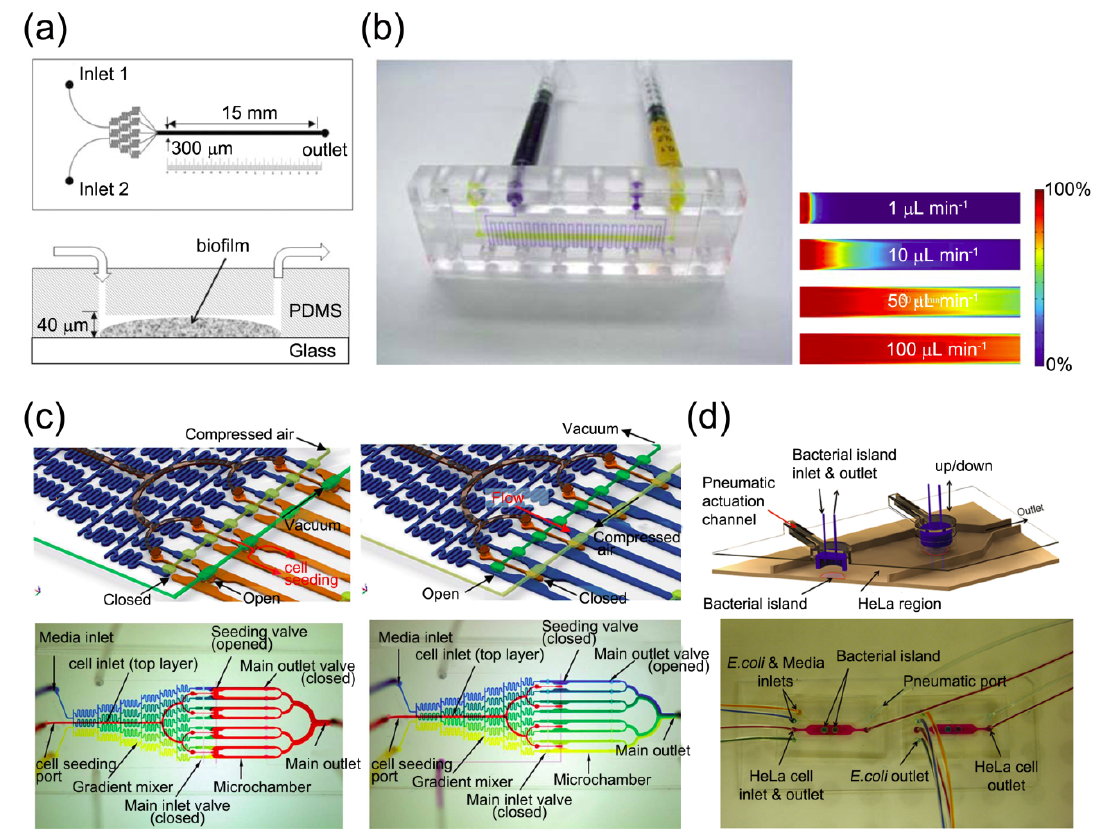
Figure 3. Microfluidic devices used in the bacterial biofilm studies. ( a ) Schematic diagram of a microfluidic device used for bacterial biofilm formation. The effects of shear stress were quantified by analyzing the biofilm area in the microfluidic channel [66]; ( b ) Multi-layer microfluidic device for generating an oxygen gradient. Blue dye was injected into the channel and yellow dye was injected into the chamber. Simulation results modeled the oxygen saturation gradient in the growth chamber [13]; ( c ) Microfluidic flow cell for high throughput bacterial biofilm studies. The device included a glass coverslip and two PDMS layers. A bacterial biofilm developed in the microfluidic channel upon exposure to the signaling molecules [75]; ( d ) Model for the co-culture of epithelial cells and bacterial biofilms. A 3D rendering image showed the pneumatically-actuated trapping regions for producing biofilm islands among the epithelial cells. The colored dyes show the different regions of the co-culture device